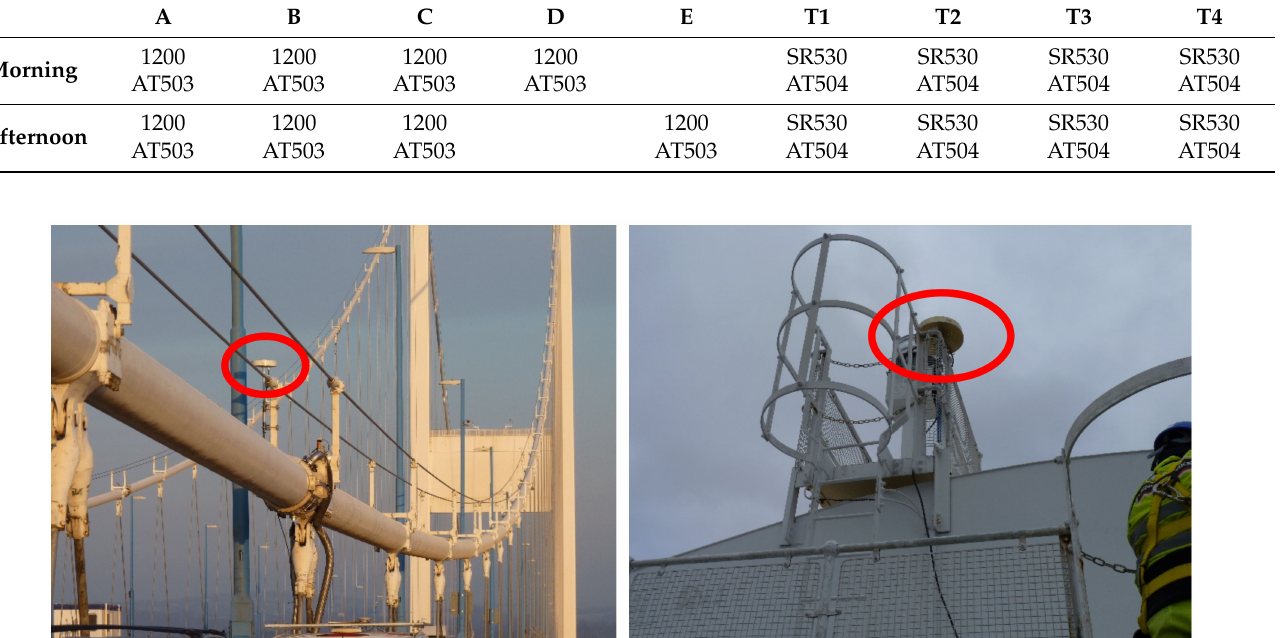
Figure 4. The illustrations of bridge cable surveying point antenna installation ( left panel ) and tower surveying point antenna installation ( right panel